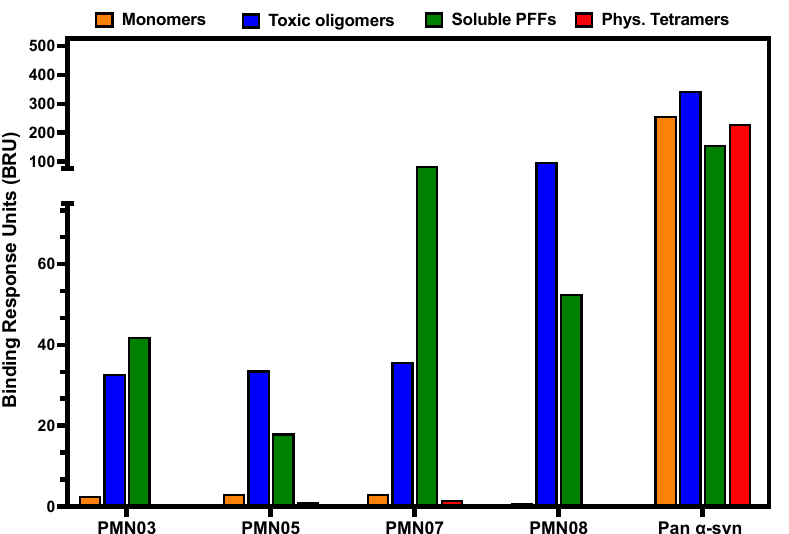
Figure 4. Selective binding of mAbs to pathogenic species of α -syn by SPR. The binding response of immobilized mAbs to α -syn monomers, toxic oligomers, soluble (sonicated) PFFs and physiologic (Phys.) tetramers was measured by SPR. An antibody reactive with all species of α -syn (Pan α -syn) was used as a positive control. The same pattern of binding was observed in 4 independent experiments.